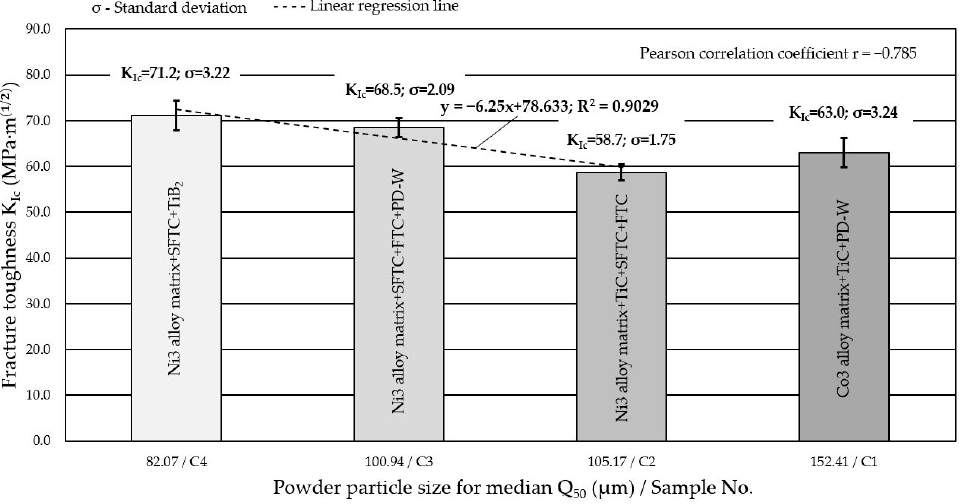
Figure 12. Influence of the particle size of the powder used for surfacing composite layers on the critical value of the stress intensity factor K Ic